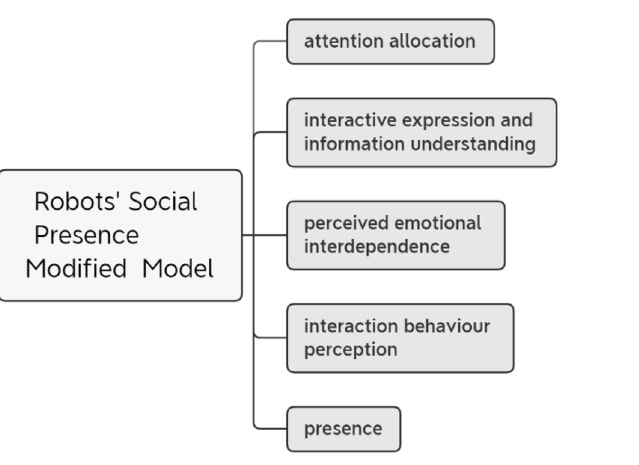
Figure 2. Modified